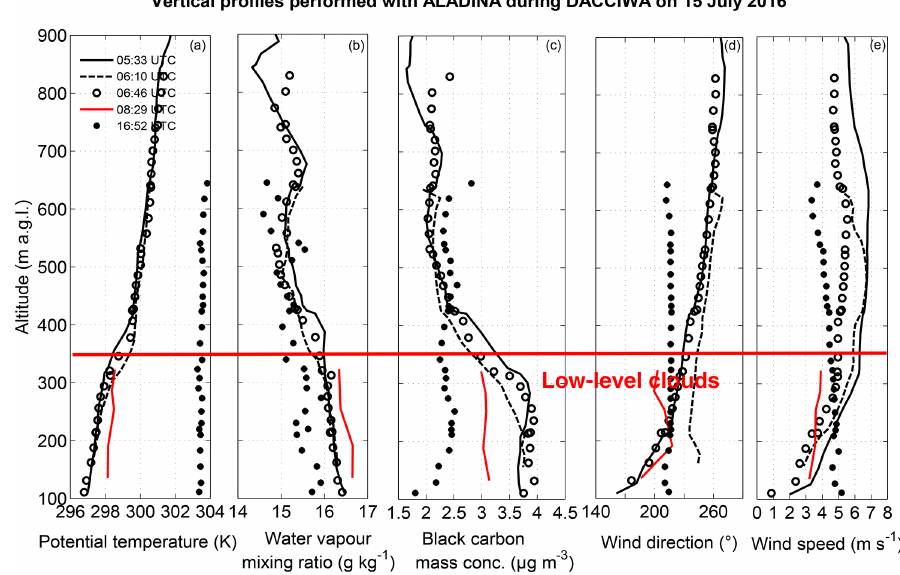
Figure 9. Five selected vertical profiles measured with ALADINA between the height of 100 and 900ma.g.l. from 05:33 until 16:52UTC on 15 July 2016. From left to right: potential temperature, water vapour mixing ratio, black carbon mass concentration, wind direction, and wind speed. The red horizontal line shows the altitude of low-level clouds formed at 07:00UTC, derived from the backscatter signal of the ceilometer (see Fig.